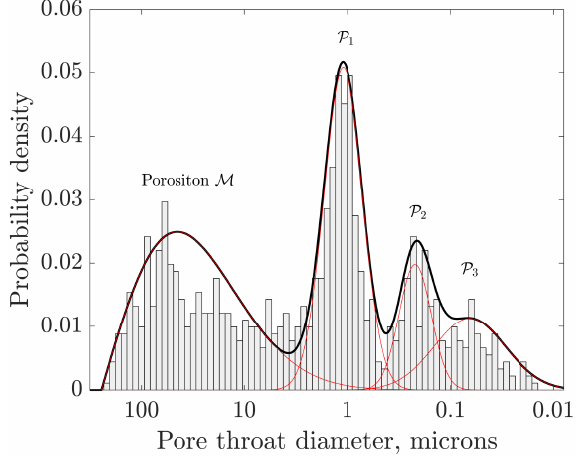
Figure 4. The semilogarithmic plot of the multimodal probability distribution for all pore throat diameters in the carbonate database in Clerke et al. [24]. Each red curve is a fit of a part of the distribution of the logarithm of pore sizes with a Generalized Extreme Value or GEV pdf for the macroporosity and three normal distributions for the microporosity. The black curve is the sum of the four